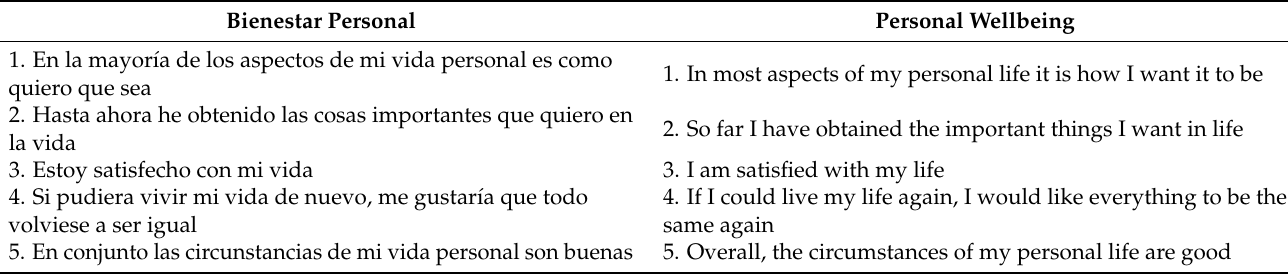
Table A1. Spanish and English versions of the Subjective Personal Wellbeing Scale.